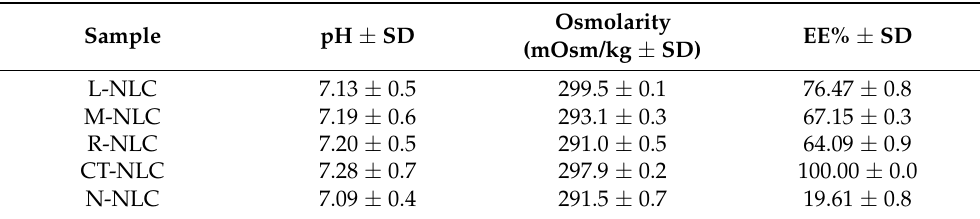
Table 1. Values of pH, osmolarity, and entrapment efficiency (EE%) ± standard deviation (SD) of NLC prepared with Lavandula (L-NLC), Mentha (M-NLC), Rosmarinus (R-NLC), Tegosoft CT (CT-NLC), and Neem (N-NLC).